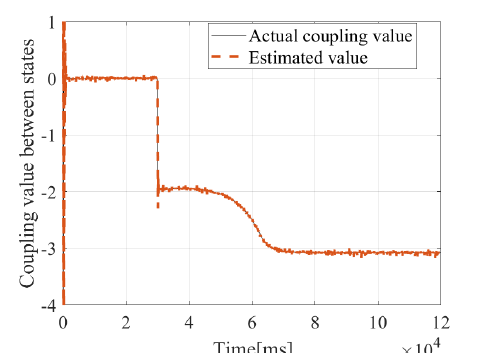
Fig. 12. Coupling estimation curve between states of vertical direction.